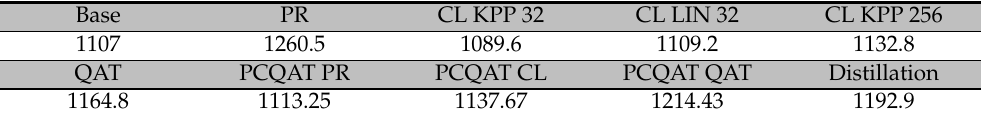
Table 2. The average time of the execution of a single training epoch for each of the